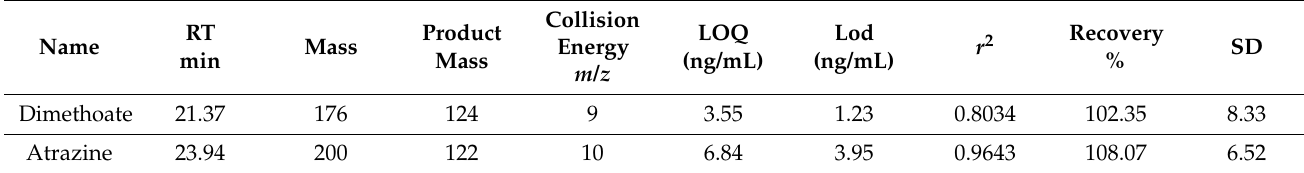
Table 2. Parameters of retention time (RT), limit of detection (LOD) and limit of quantification (LOQ), recovery % and GC–MS/TSQ target mass of SRM scanning mode.